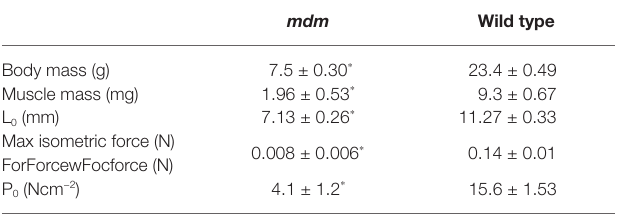
TABLE 1 | Physiological characteristics of wild type and mdm soleus